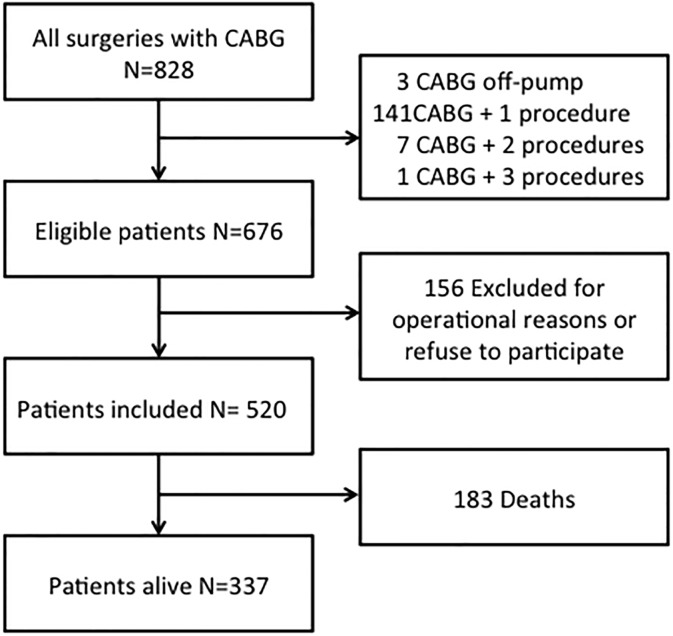
Study flow chart.